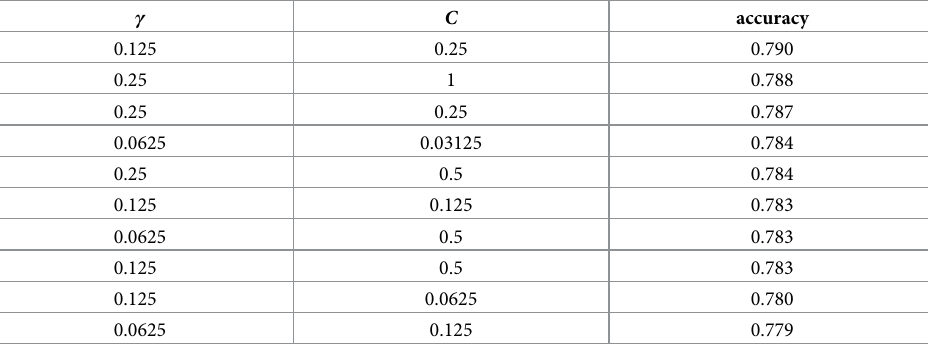
Table 6. Results of infection prediction—SVM with 3-fold cross-validation.